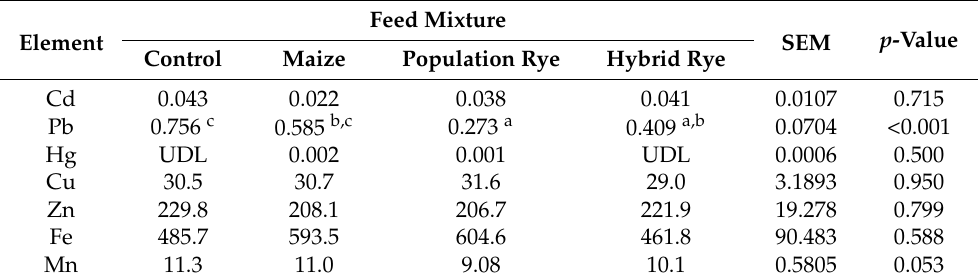
Table 7. The mean content of heavy metals (mg/kg dry tissue, b. wt.) in the liver of pigs fed control and experimental